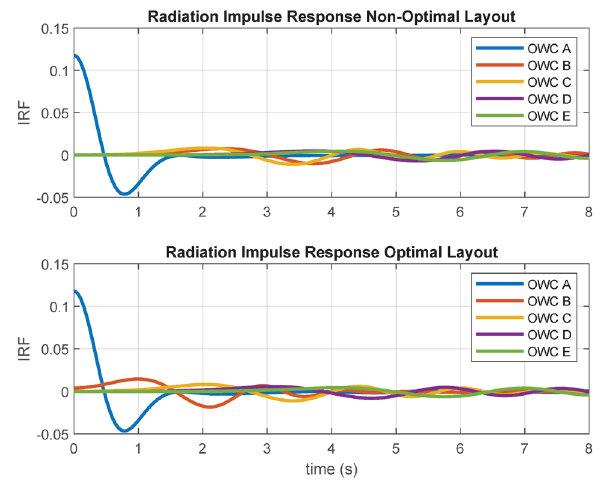
Fig. 4. Radiation Impulse Response functions on WEC A for non-optimal and optimal layouts. Notice that the amplitude and time of peak are dependent on the distance from WEC A as